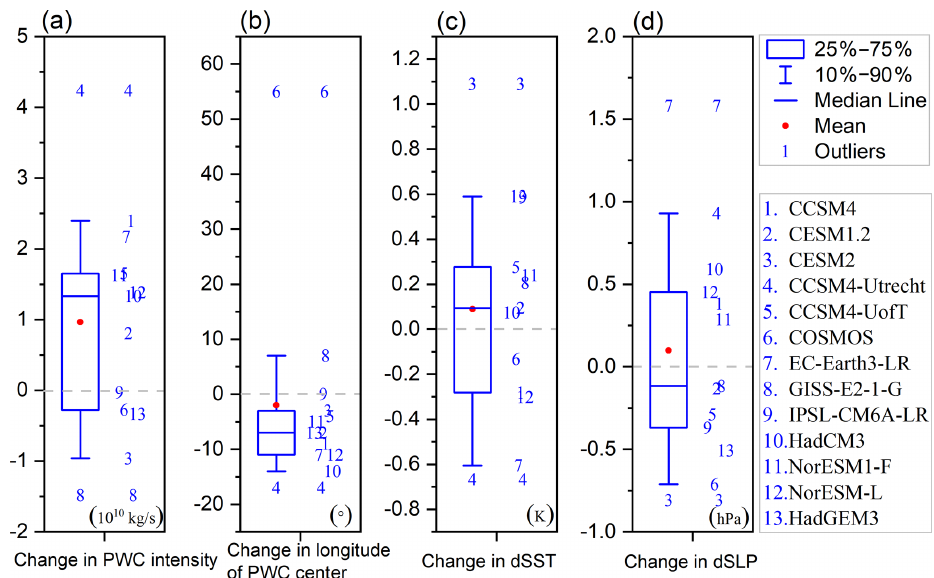
Figure 10. Changes in the annual mean of the (a) intensities of the Pacific Walker circulation (PWC; in 10 10 kgs − 1 ), (b) longitude of the PWC cell center (in ◦ ), (c) dSST (in K), and (d) dSLP (in hPa) for mid-Pliocene simulations compared with the PI simulation. Here, the PWC intensity is defined as the vertically integrated zonal mass stream function (ZMS; Bayr et al., 2014; Schwendike et al., 2014) averaged in the equatorial Pacific (140 ◦ E–120 ◦ W), and the location of the PWC cell center is the longitude of the maximum ZMS. The dSLP and dSST are defined as the difference in SLP and SST across the equatorial Indo-Pacific (160–80 ◦ W, 5 ◦ S–5 ◦ N minus 80–160 ◦ E, 5 ◦ S–5 ◦